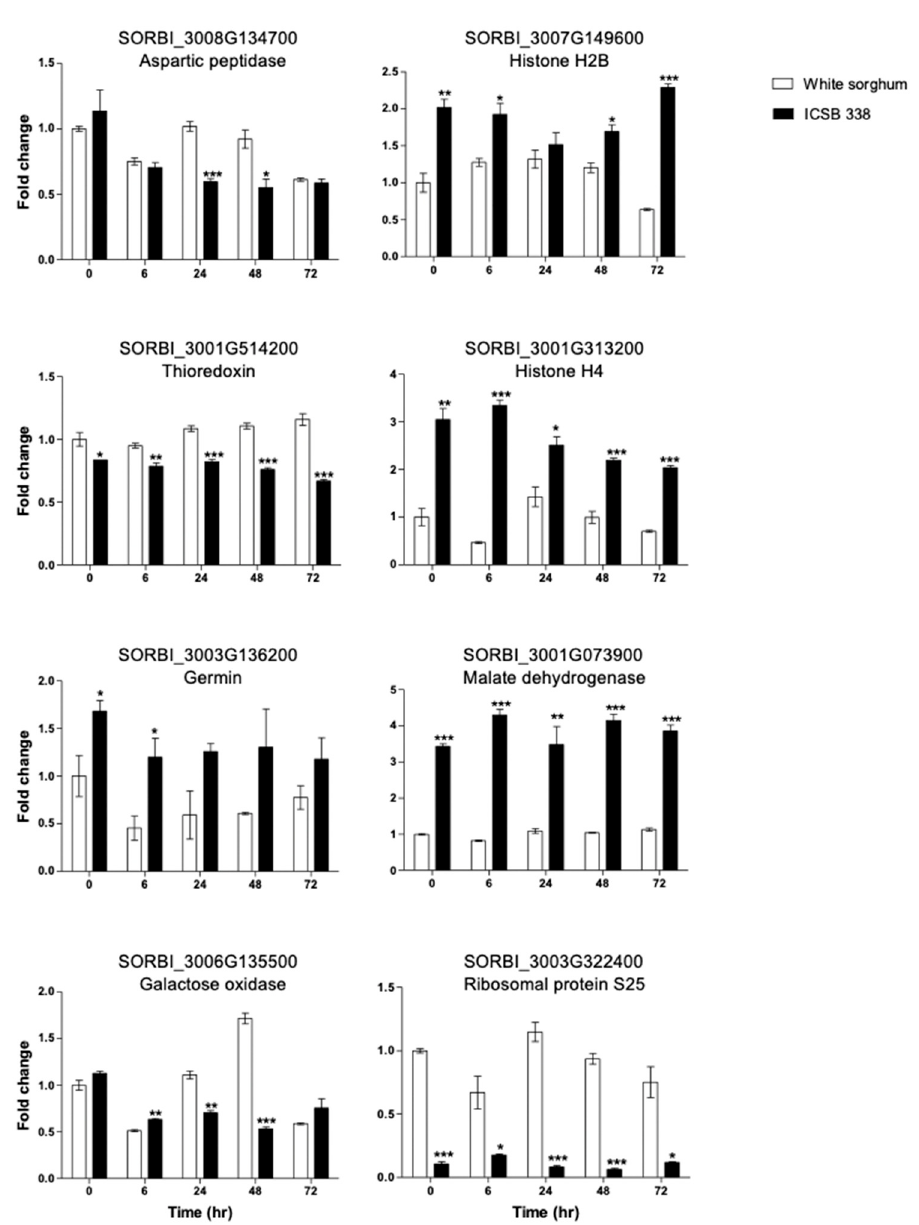
Figure 7. Sorbitol-induced gene expression in sorghum cell suspension cultures. ICSB 338 and White sorghum cell suspension cultures were exposed to 400 mM sorbitol-induced osmotic stress for 72 h. The cell cultures were harvested at 0, 6, 24, 48 and 72 h for quantitative real-time polymerase chain reaction (qRT-PCR). Error bars represent mean ± SE ( n = 3). *, ** and *** indicate significant di ff erences between ICSB 338 and White sorghum means at each time point, p ≤ 0.05, 0.01, and 0.001, respectively.